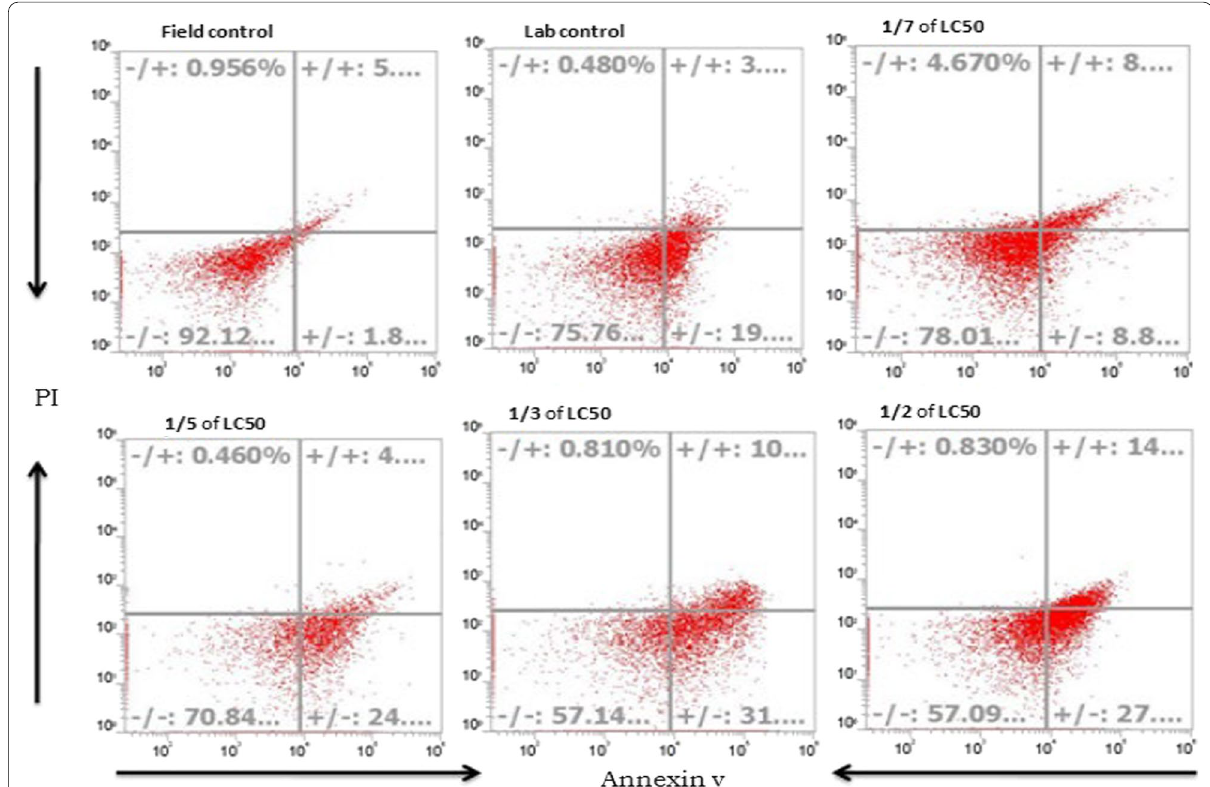
Fig. 3 Flow cytometry analysis revealed concentration-dependent apoptosis